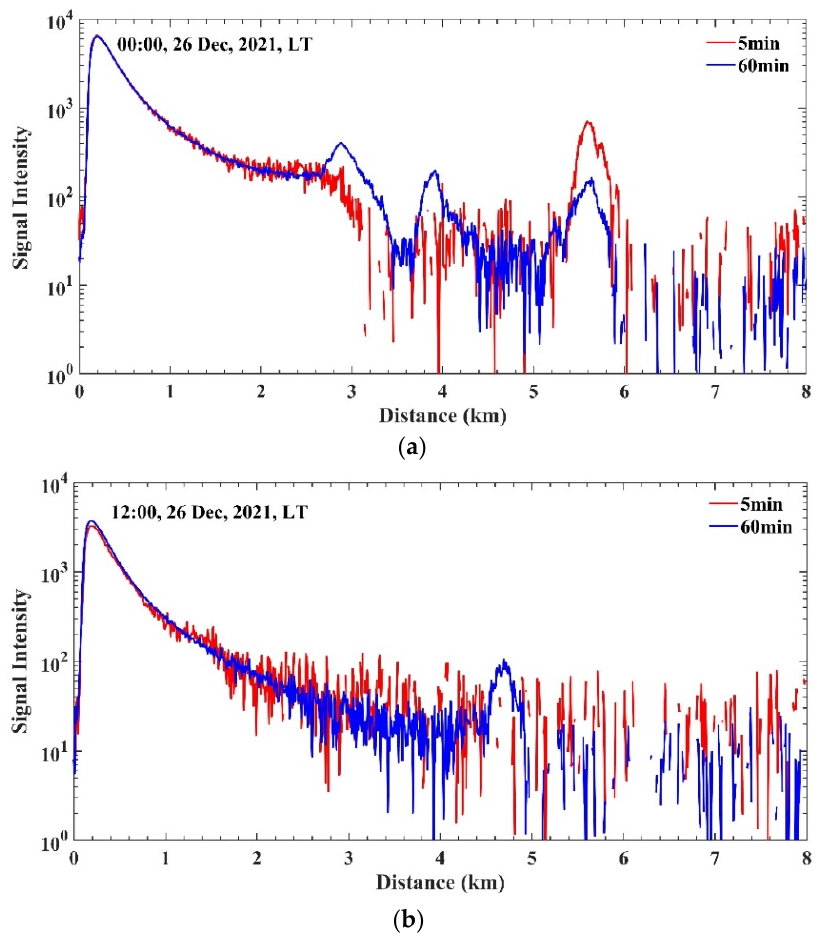
Figure 8. The acquired aerosol and cloud signal with spatial resolution of 9.8 m in different integral durations of 5 min and 60 min, respectively. ( a ) Signals at midnight; ( b ) Signals at noon.